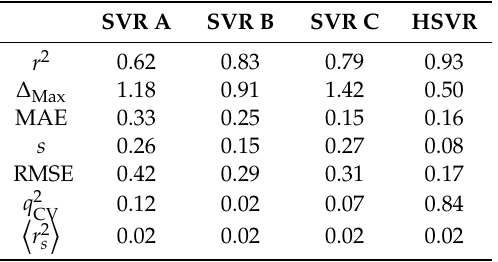
Table 2. Statistic evaluations, namely correlation coe ffi cient ( r 2 ), maximal absolute residual ( ∆ Max ), mean absolute error (MAE), standard deviation ( s ), RMSE, leave one out cross-validation correlation coe ffi cient ( q 2 ), and average correlation coe ffi cient of Y -scrambling ( < r 2 s > ) evaluated by SVR A, SVR B, CV SVR C, and HSVR in the training set. SVR A